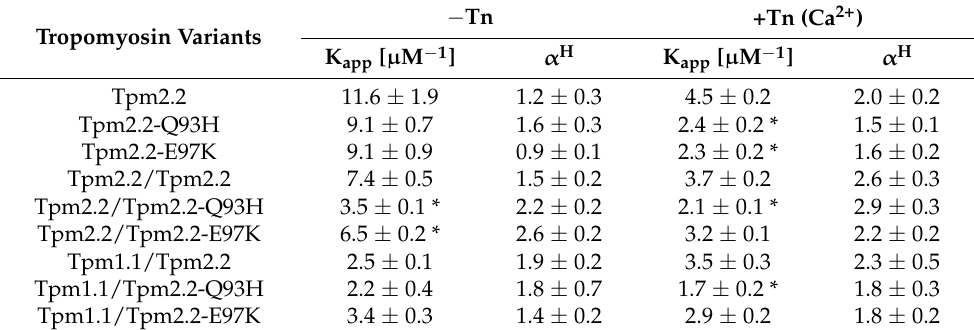
Methods. * Statistically significant differences between wild type and mutant tropomyosin ( p ≤ 0.05). K app , apparent affinity constant; α H , Hill